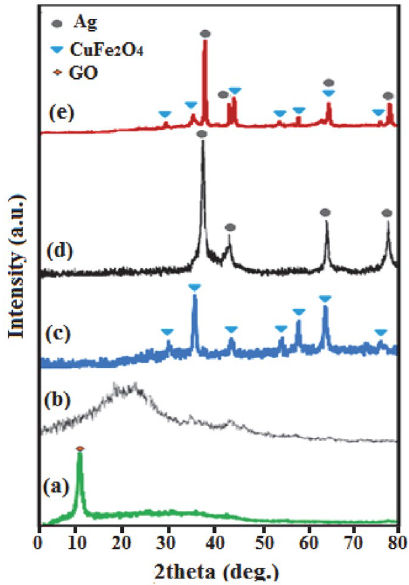
Figure 1. XRD patterns of (a) GO, (b) rGO, (c) CuFe 2 O 4 , (d) Ag and (e) Ag/CuFe 2 O 4 /rGO